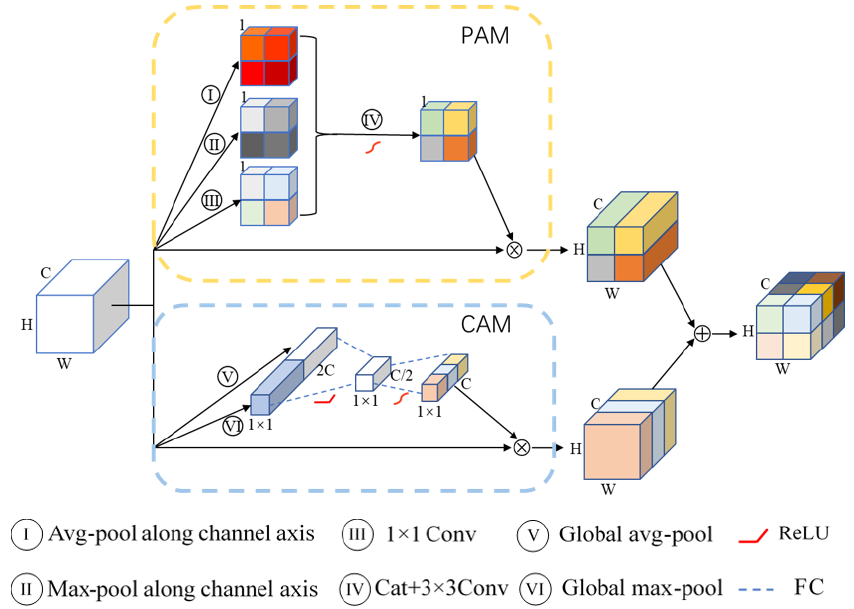
Figure 3. Illustrating the pipeline of dual attention module (DAM). (1) form the PAM in the yellow dashed box. (2) form the CAM in the blue dashed box. Weights are represented in different